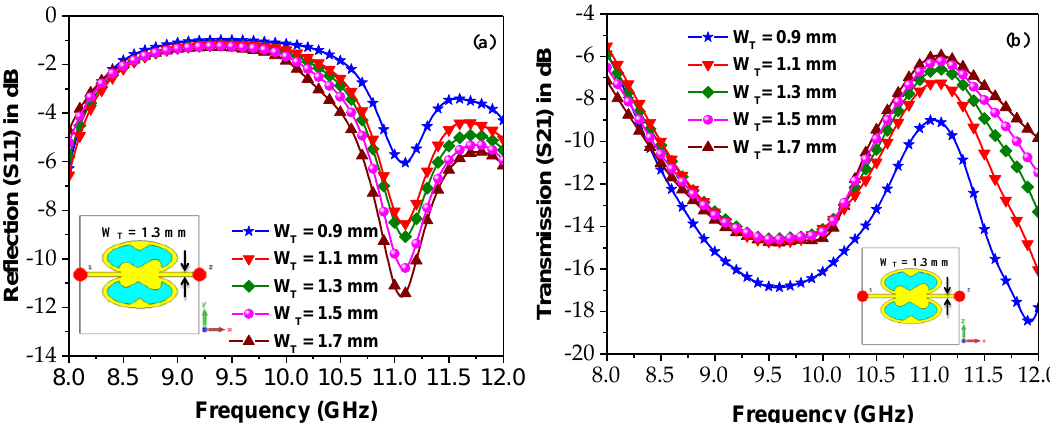
Figure 8. ( a ) Parametric study of the effect of transmission line width on the reflection spectrum ( a ) and ( b ) transmission spectrum.